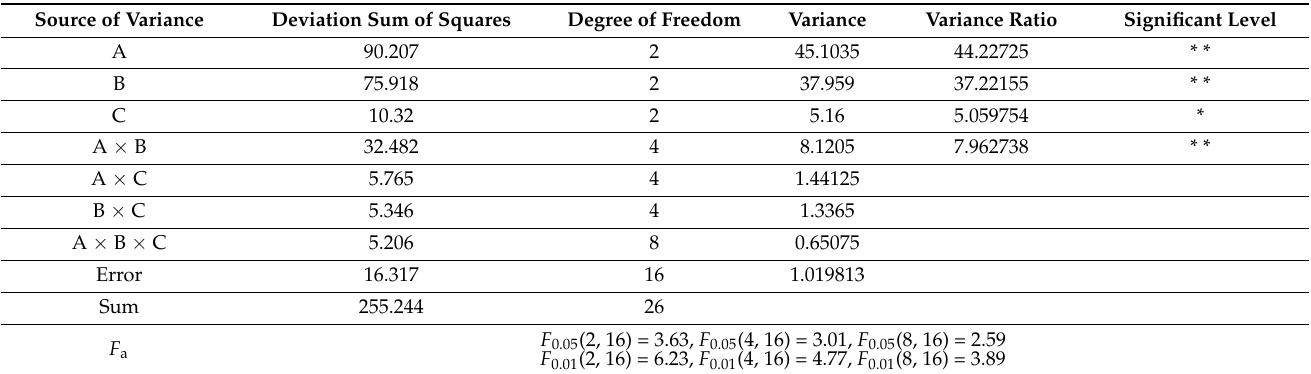
Table 6. Variance analysis of the maximum X-axis